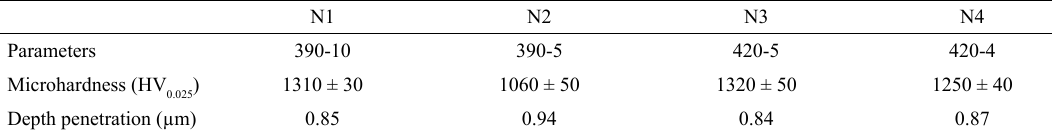
Figure 4. Hardness profiles of nitrided samples. Table 2. Microhardness measurements results and calculated mechanical properties